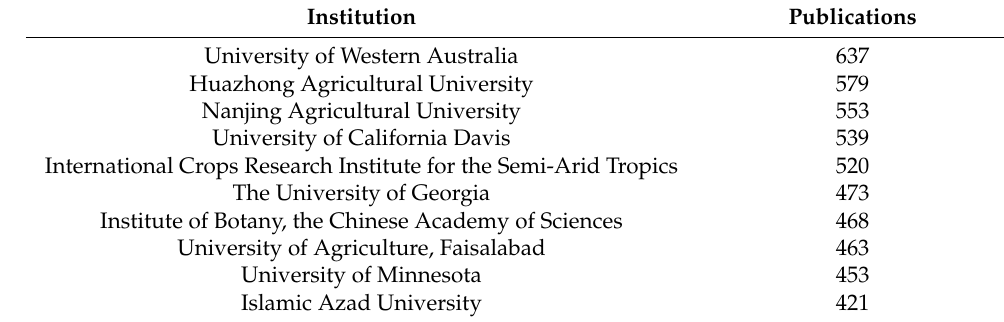
Table 3. Top ten most marked